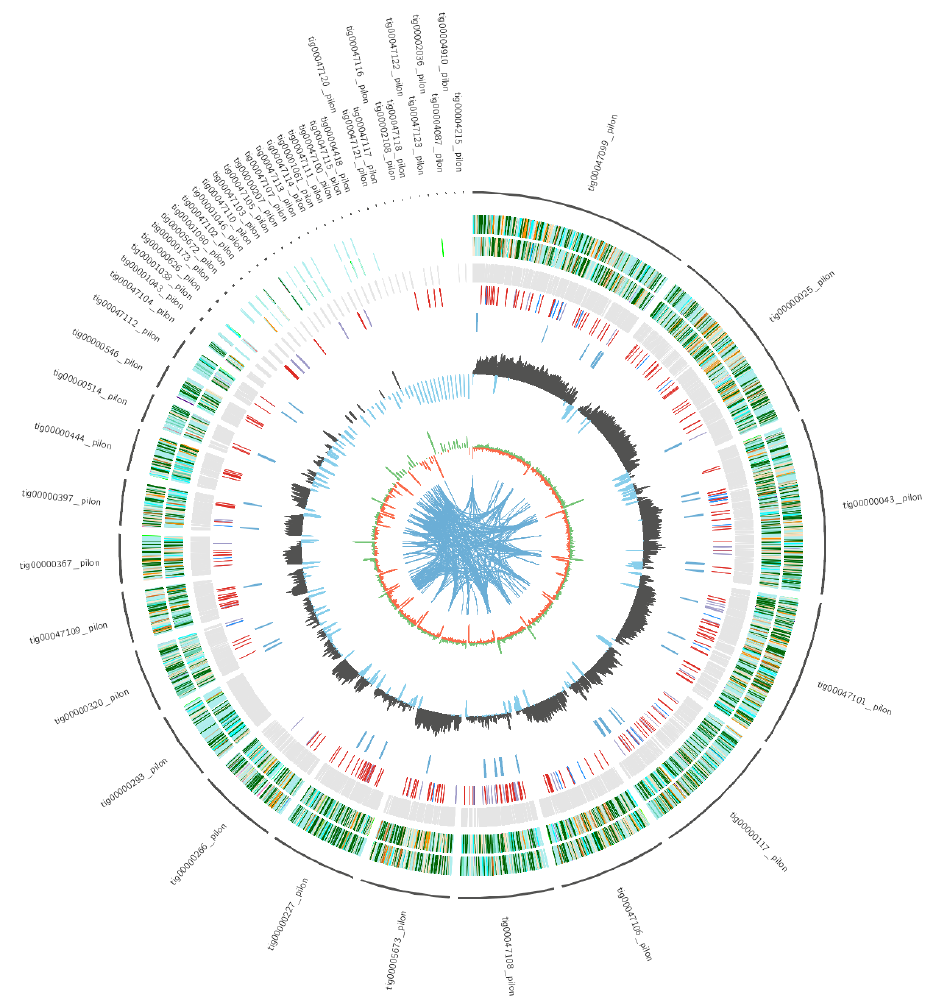
Figure 2. Genome diagram of strain R1. Table 1. Genomic assembly and functional annotation of strain R1 genome.